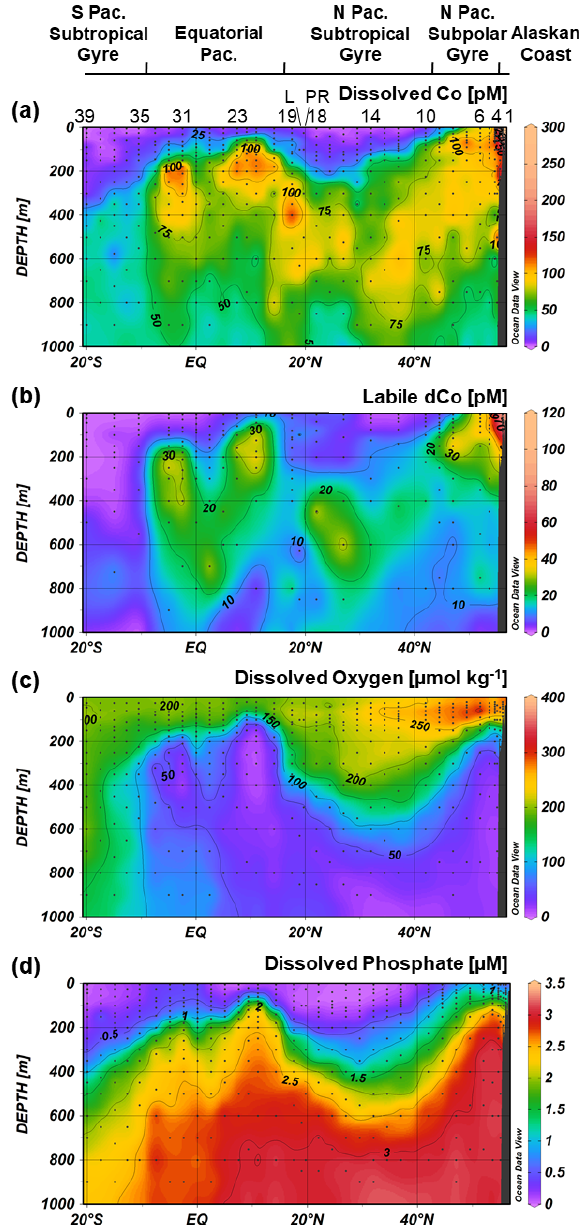
Figure 5. Upper-ocean transects of dissolved Co (a) , labile dis- solved Co (b) , dissolved phosphate (c) and dissolved oxygen (d) along the GP15 cruise track. Weighted-average gridding is used to interpolate between data points. Select station numbers are shown in panel (a) , with the Loihi Seamount station labeled as “L” and the Puna Ridge station labeled as “PR”.